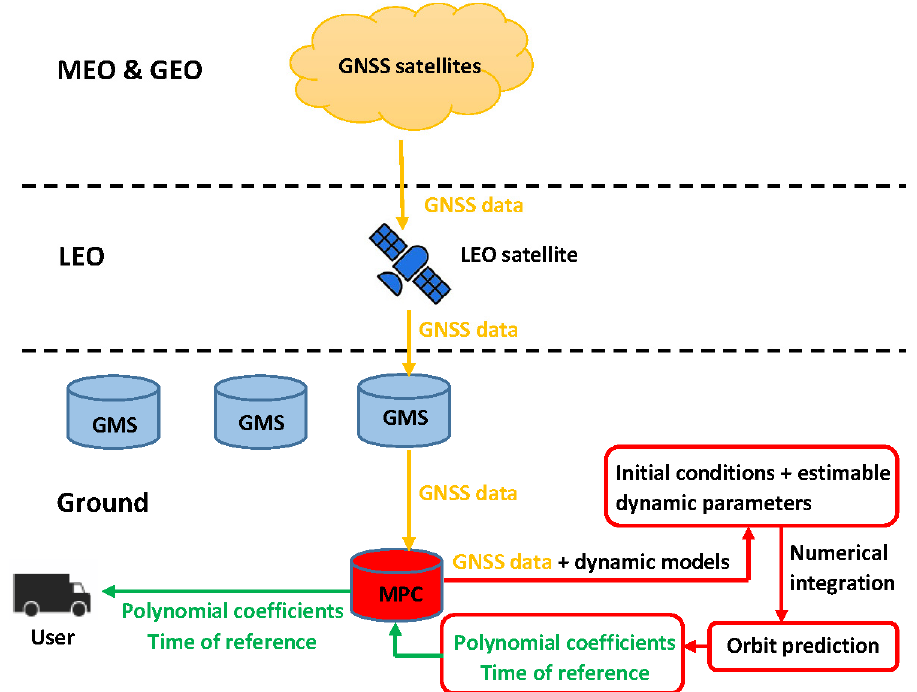
Figure 6. Process of generating the Level B orbital products.